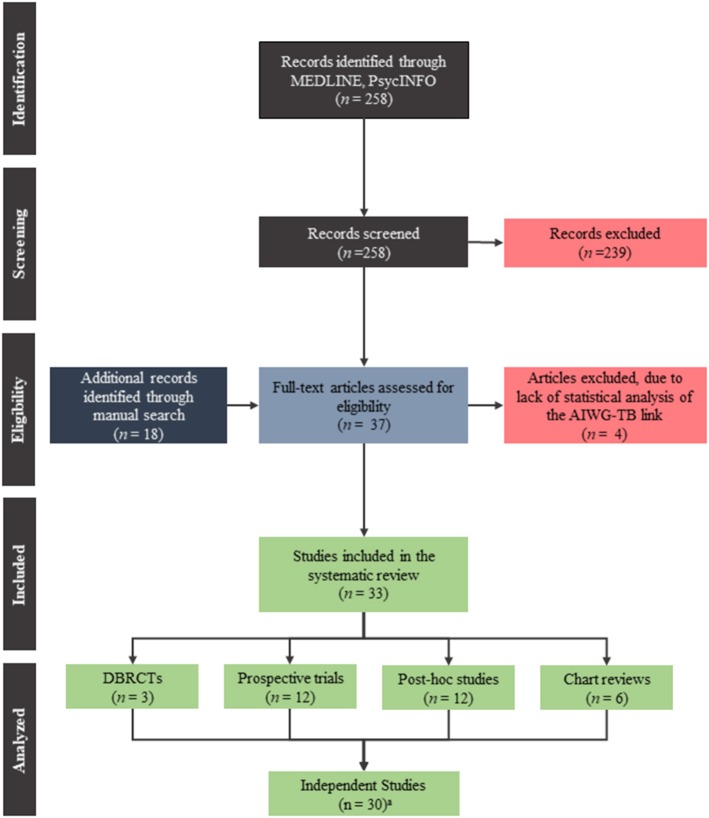
PRISMA flow diagram of the search used to find the publications included in this systematic review.